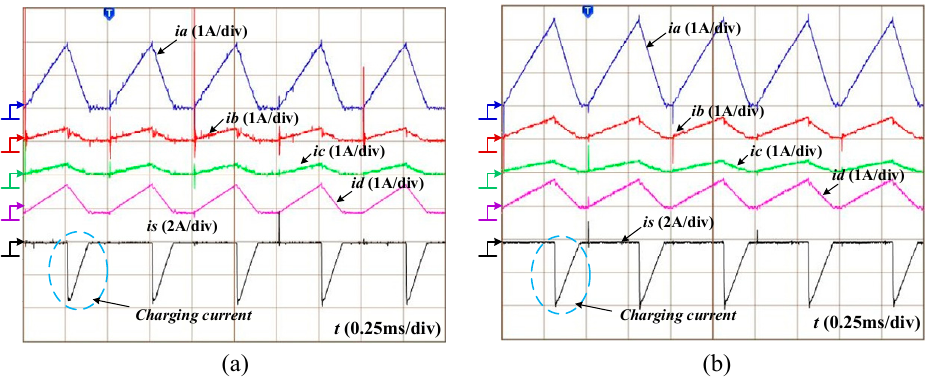
Figure 20. Experimental waveforms of battery charging performance: ( a ) duty cycle: 50% and ( b ) duty cycle: 60%.